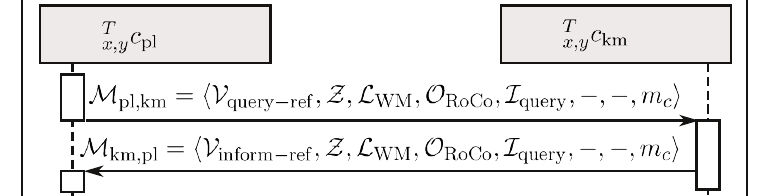
Figure 9. Interaction protocol